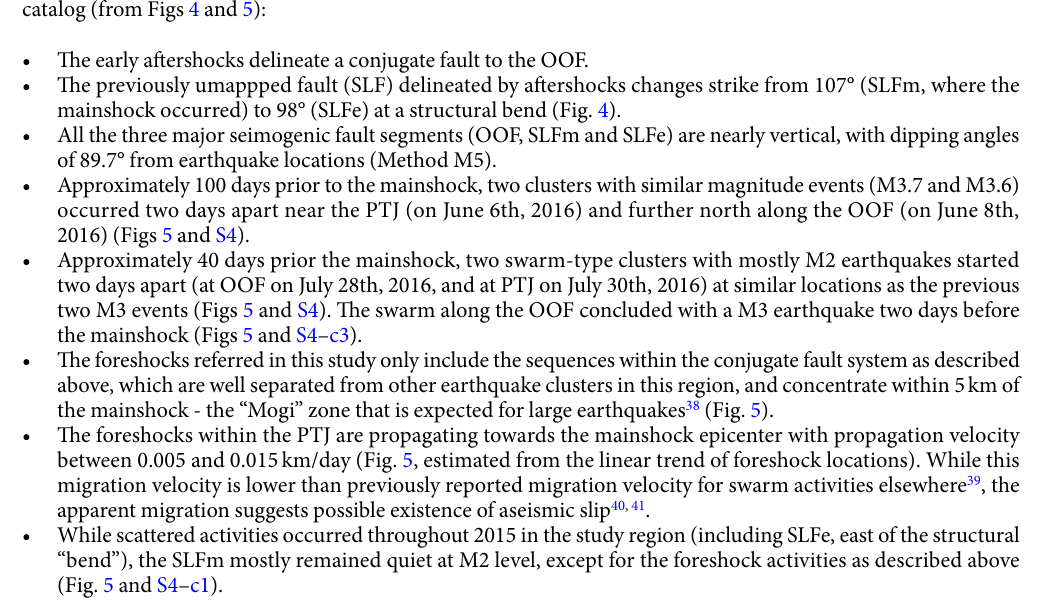
double-difference algorithm combining analyst phase picks from the OGS, precisely measured differential-times via waveform cross-correlation and a 3D velocity model (see Method M5). The final catalog has a magnitude of completeness (Mc) of 2.0, and reveals several interesting observations. All the relocated earthquakes are located within the crystalline basement (the upper bound of the basement depth is between 1 km and 1.4 km) (Fig. 4), well below the depth interval of the Arbuckle Group where injection activities are occurring (Figure S3). We also use a catalog of 53 focal mechanism solutions from the OGS focal mechanism catalog to analyze seismogenic faulting.